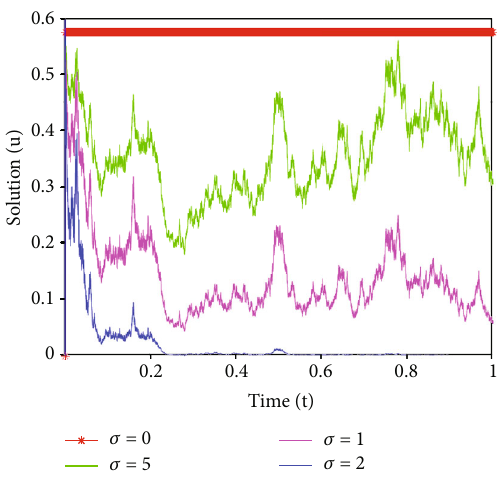
Figure 4: 2D diagrams of Equation